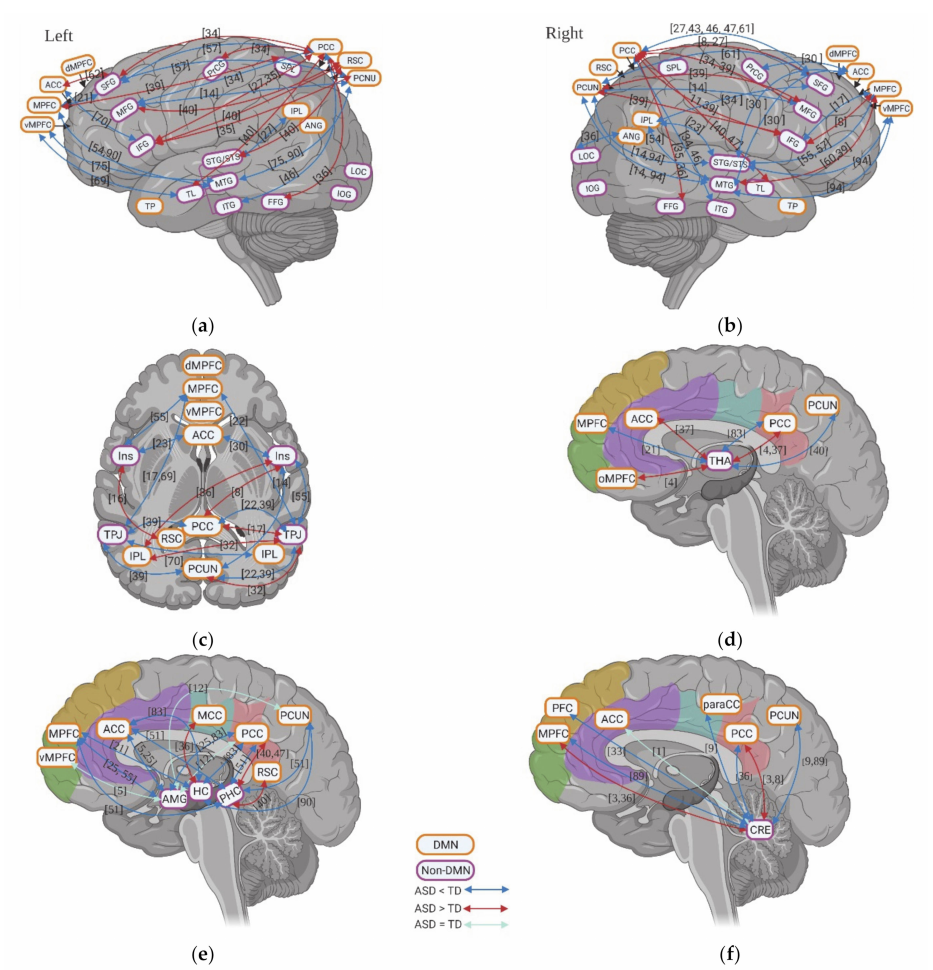
Figure 5. Functional connectivity between DMN and non-DMN regions for individuals with ASD compared to TD. In this figure, ( a , b ) shows the functional connectivity between DMN and non-DMN regions in left and right hemisphere; ( c ) shows functional connectivity between DMN and Insular (Ins), temporo-parietal junctions (TPJ); ( d ) shows the functional connectivity between thalamus (THA) and DMN; ( e ) shows the functional connectivity between DMN and amygdala (AMG), hippocampus cortex (HC), and parahippocampal cortex (PHC); ( f ) shows the functional connectivity between cerebellum (CRE) and DMN. The numbers in the figure correspond to the study numbers in Table